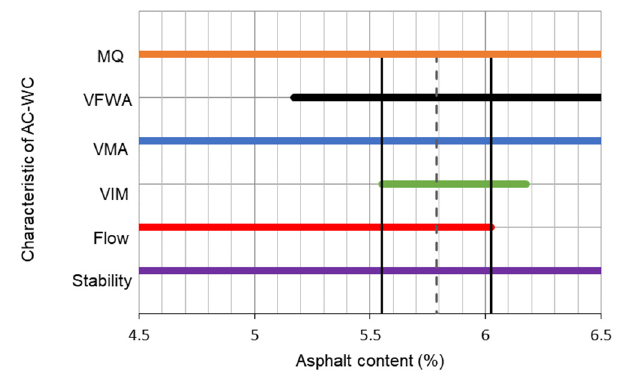
Figure 4. Optimum asphalt content of AC-WC mixture.